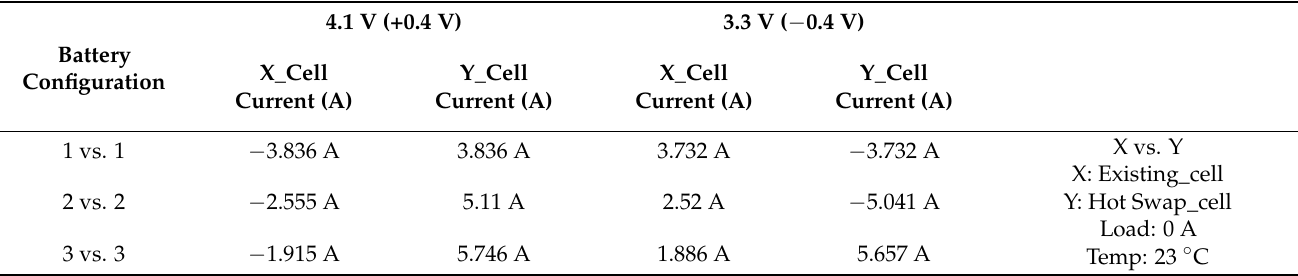
Table 3. Effect of battery parallel configuration on hot-swap circulating